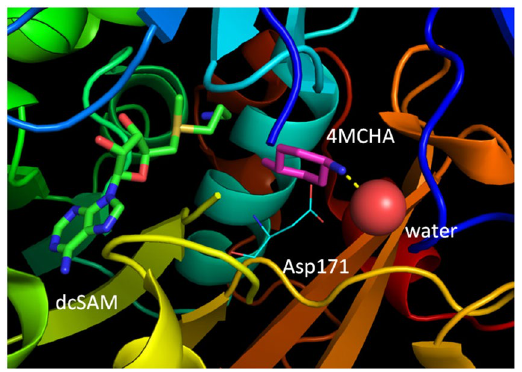
Figure 1. The crystal structure of the TcSpdSyn putrescine-binding site with trans-4-methylcyclohexylamine (4MCHA) (PDB ID code: 4YUW). 4MCHA binds to the putrescine-binding site and interacts with Asp171 through a salt bridge. A water molecule interacts with the 4MCHA amino